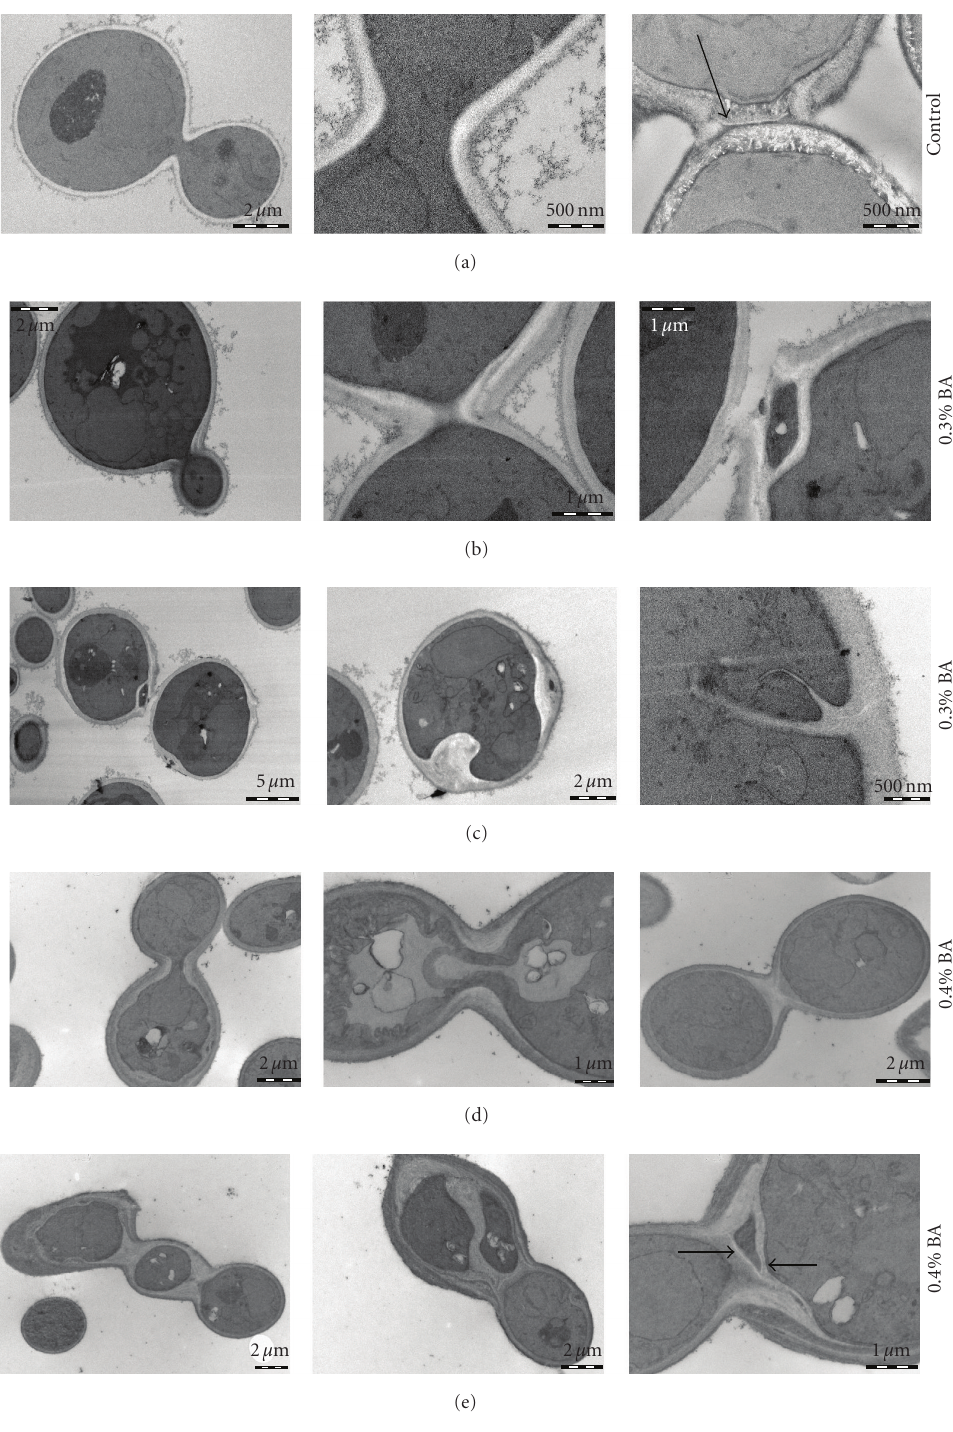
Figure 5: Electron micrographs of YPH499 cells grown in the presence of 0.3% and 0.4% BA. Cell wall chitin appears electron translucent. (a) No BA. Left: a mother-daughter pair; Middle: a close-up of the bud neck; Right: a completed trilaminar septum. Note the thin layer of chitin (primary septum; arrow) in the center of the structure. (b) Cells grown with 0.3% BA. Left: a mother-daughter pair; Middle: a close-up of the bud neck; Right: a completed septum. (c) Examples of other cell wall abnormalities in cells grown with 0.3% BA. Left: cell wall thickening and lacunae at the cell periphery; Middle: massive cell wall protuberances; Right: a septum forming at an ectopic location. (d) Cells grown with 0.4% BA. Left: a mother-daughter pair; Middle: a close-up of the bud neck; Right: a completed default septum. (e) Examples of other cell wall abnormalities in cells grown with 0.4% BA. Left: a chain of cells connected by default septa; Middle: a large cell wall structure spanning the entire length of the cell; Right: chitin-rich cell wall material deposited at the bud neck with two embedded aberrant septa